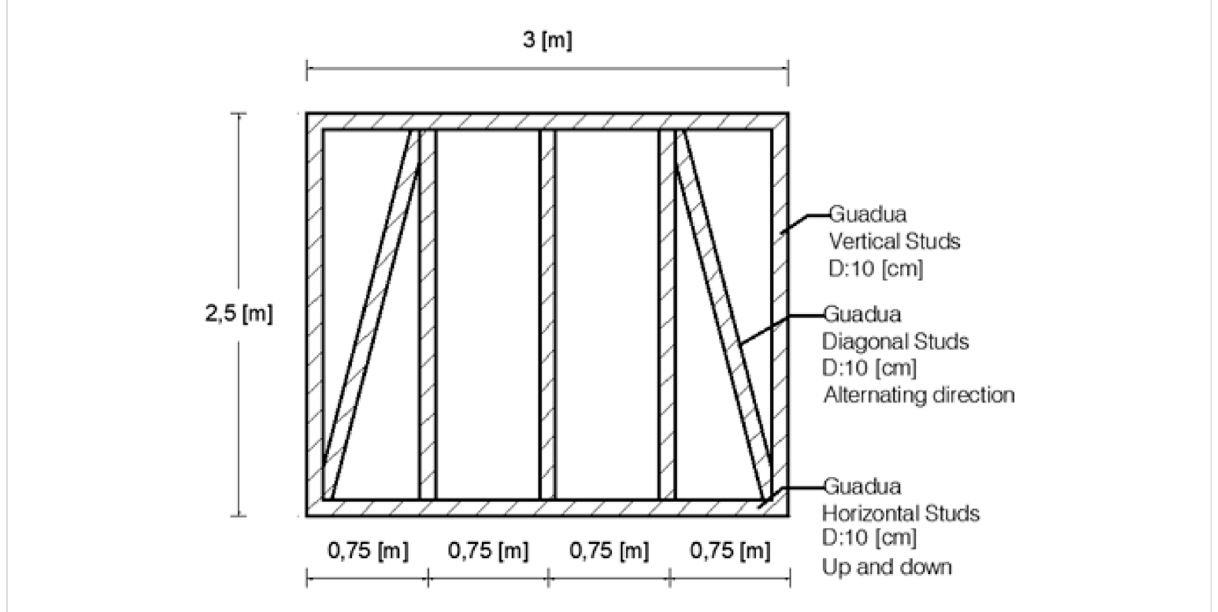
FIGURE 9 Design Framework panel. Design inspired by the publication by López-Muñoz (2015).